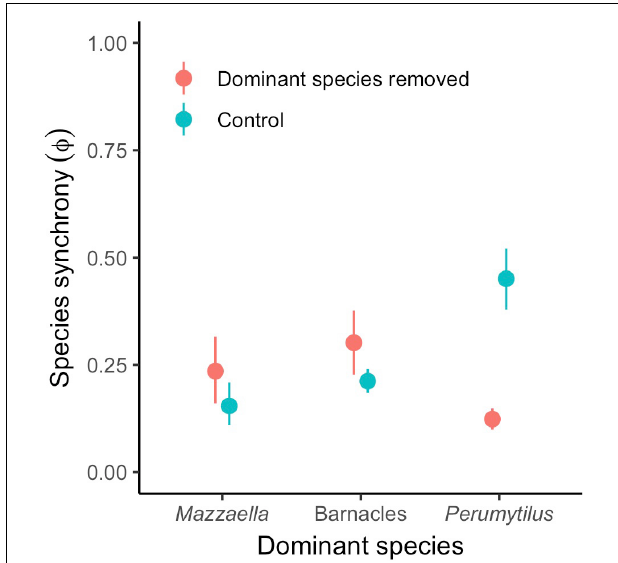
FIGURE 3 | Community-wide synchrony among subordinate species in each community type ( Mazzaella-, barnacle-, or Perumytilus- dominated community). The range of ϕ is [0, 1], with 1 = perfectly synchronous species fluctuations and 0 = perfectly asynchronous, compensatory species fluctuations. Values are mean ± 95% confidence intervals. All communities statistically differed from 1 (one-tailed t -tests: t 9 = − 42.2, P < 0.001; t 16 = − 17.5, P < 0.001; t 28 = − 38.2, P < 0.001, respectively), indicating prevalent compensatory dynamics across the region. The removal of the dominant species systematically increased the strength of species compensation in the Perumytilus communities, but not in the others (Gamma GLM, R 2 = 0.45, P < 0.001 for Perumytilus